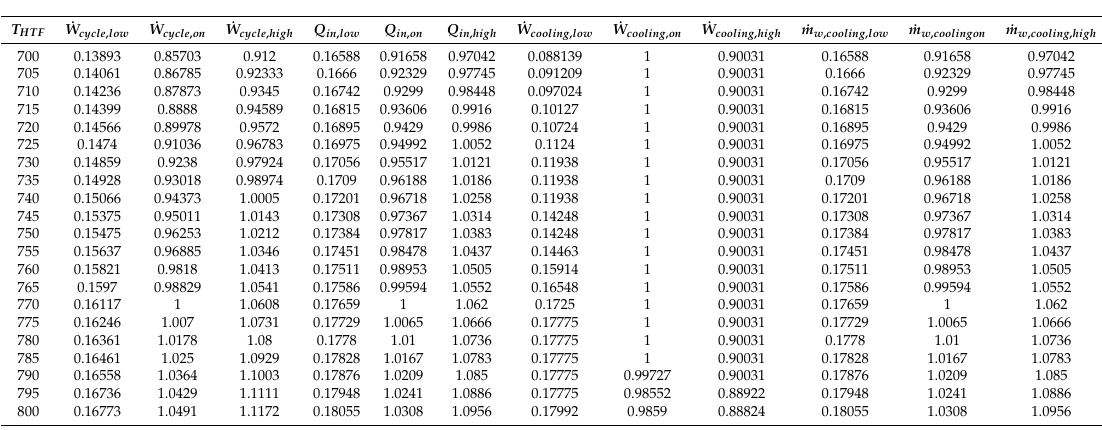
Table A4. Performance as a function of HTF temperature (MOD1) table for Partial Cooling cycle. “Low”, “On” and “High” respectively refer to the three normalised mass flows employed: 0.2, 1 and